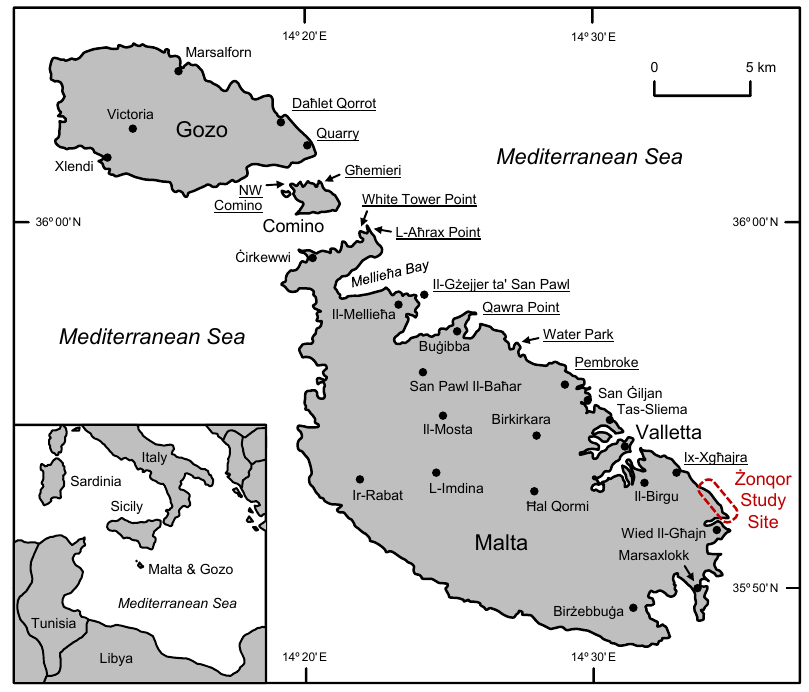
Figure 1. Location of the ˙Zonqor study site in southeast Malta. Other sites in the Maltese islands investigated by Mottershead et al. [7,25,26] and Biolchi et al. [8] are